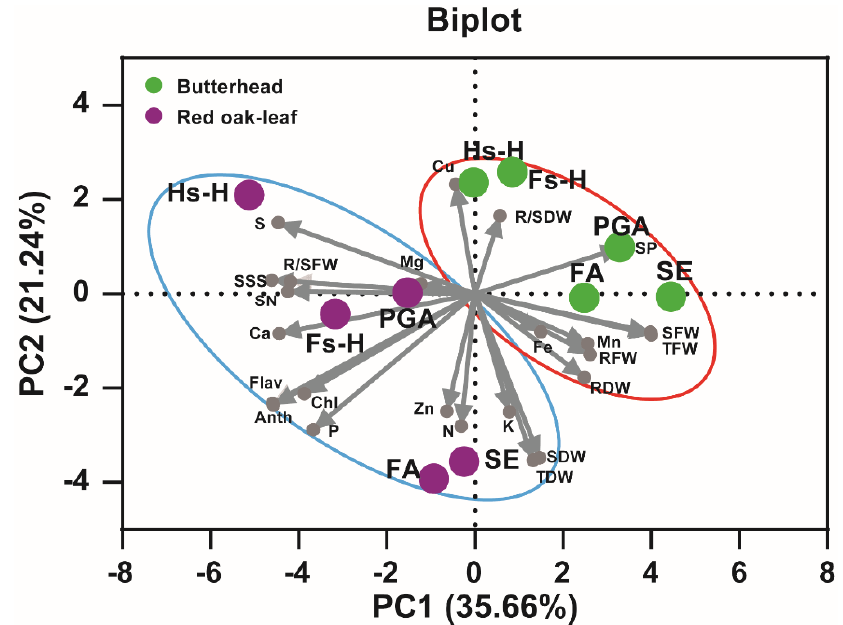
Figure 5. Principal component pattern for correlations of yield, quality, and nutrient concentration traits in butterhead and red oak-leaf. SFW — shoot fresh weight; SDW — shoot dry weight; RFW — root fresh weight; RDW — root dry weight; TFW — total fresh weight; TDW — total dry weight; R/SFW — ratio of root to shoot in fresh weight; R/SDW — ratio of root to shoot in dry weight; SN — shoot nitrate concentration; SSS — shoot soluble sugar concentration; SP — soluble protein; Chl — leaf chlorophyll content; Flav — leaf flavonoids content; Anth — leaf anthocyanins content; N, P, K, S, Ca, Mg, Fe, Mn, Cu, and Zn — their respective concentrations in the shoot.